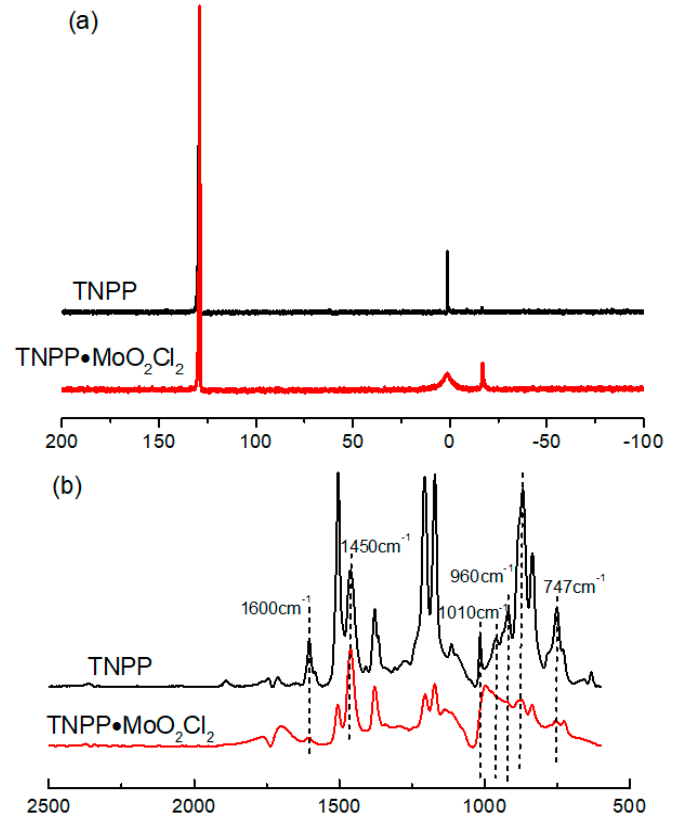
Figure 2. Microstructure characterization of catalysts by 31 P NMR and FTIR analyses. ( a ) 31 P NMR spectra of main catalyst. ( b ) IR spectra of main catalyst.